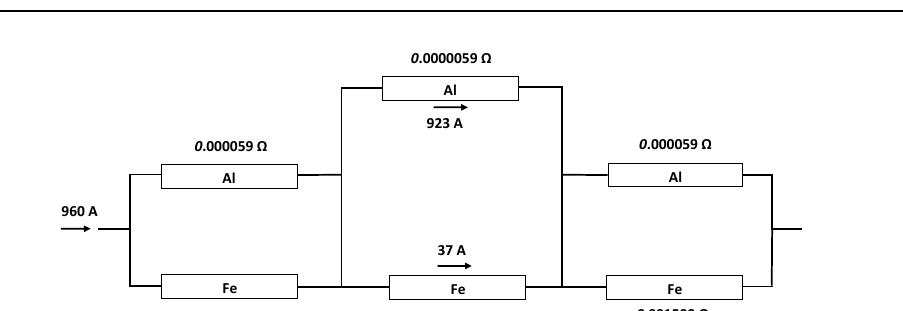
Figure 9. Theoretical current distribution between the steel core and the aluminum coat. Picture of measurement with interrupted aluminum coat.